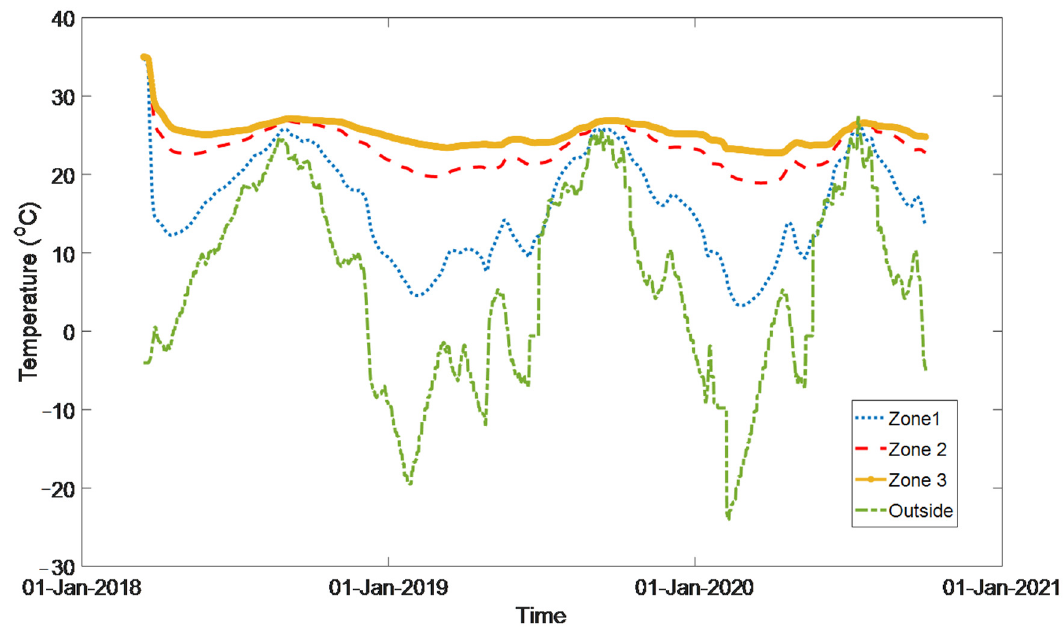
Figure 5. Temperatures at all three zones.